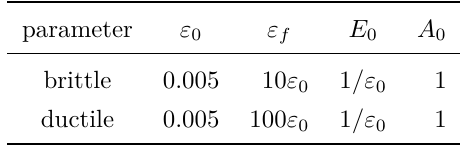
Table 1. Parameters of the lattice